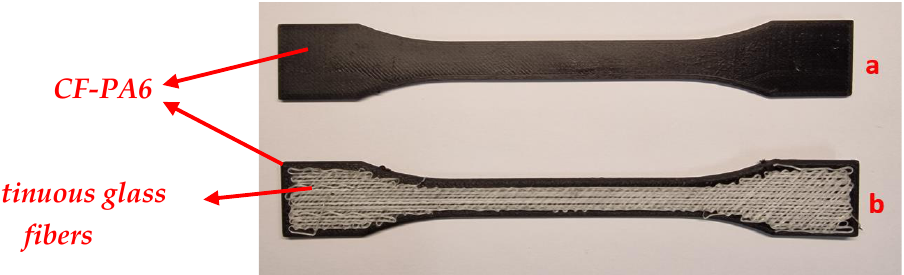
Figure 10. The manufactured CF-PA6 ( a ) and CF-PA6 reinforced with continuous glass fiber ( b ) specimens.